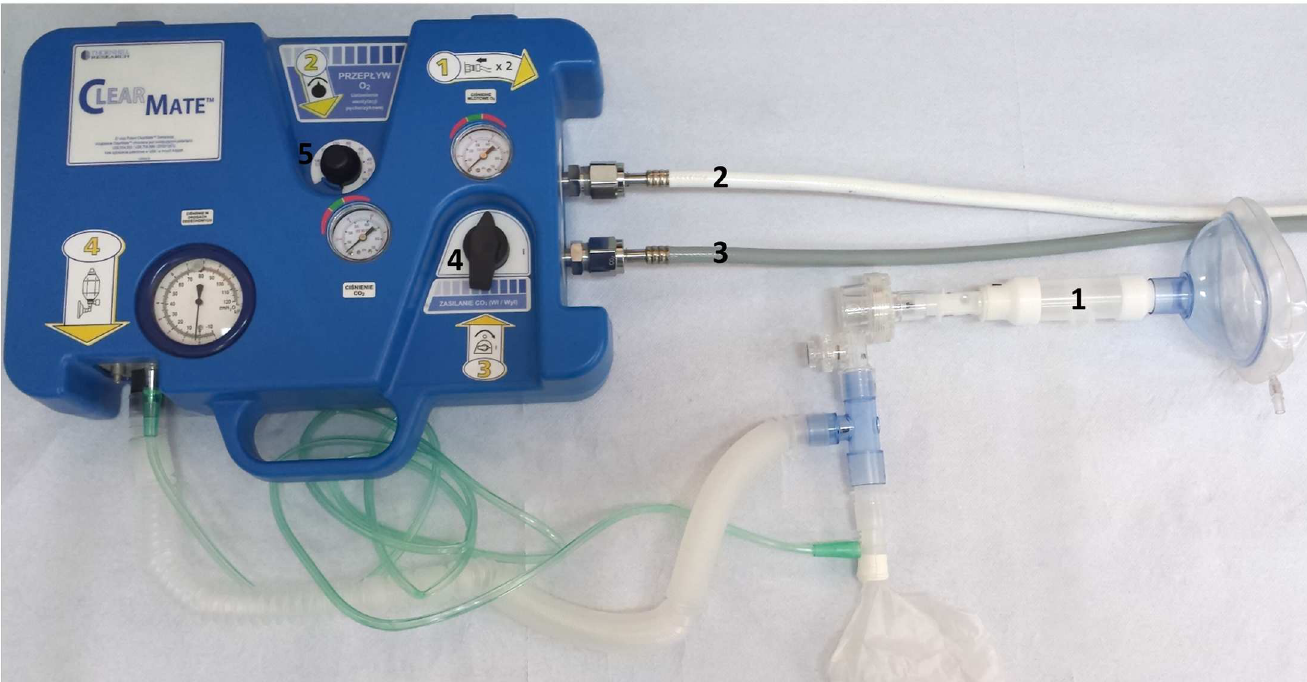
Fig 1. The ClearMatedevice and the breathing circuit used in the study. The device used duringthe study and the elementsof the breathingcircuit: 1- spirometer flow head, 2 –oxygensupply, 3 –carbondioxidesupply, 4 –carbondioxidesupply on/off switch, 5 –oxygenflow rate